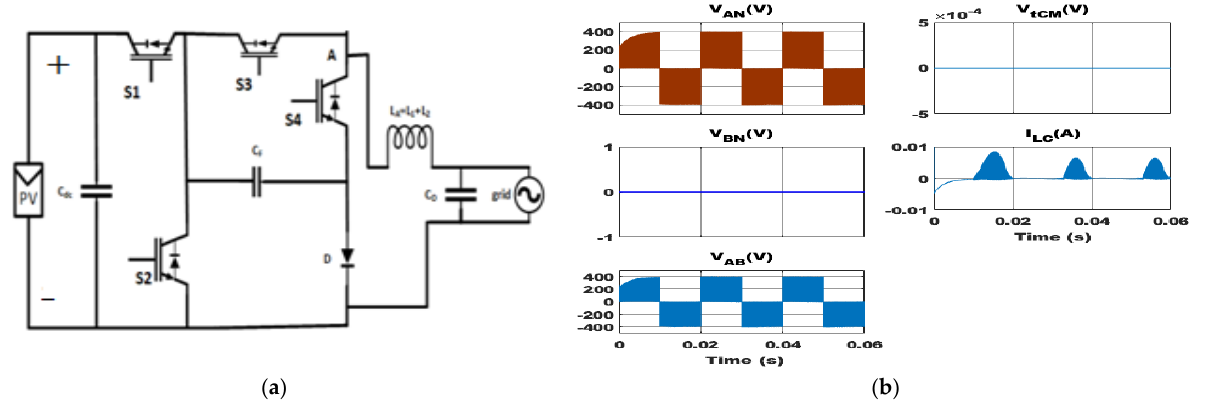
Figure 20. Flying Capacitor Type-I topology: ( a ) circuit structure; ( b ) simulation results.